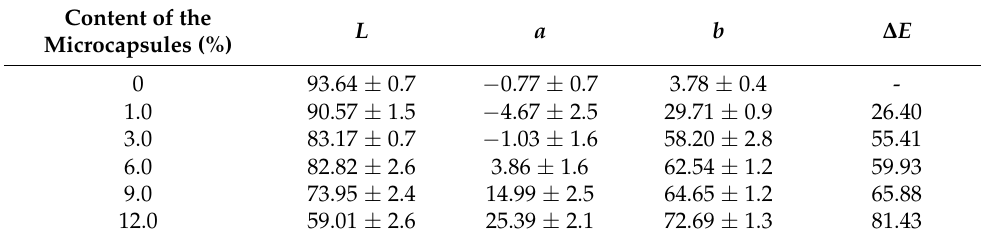
Table 13. Chromaticity value and color difference value of the paint